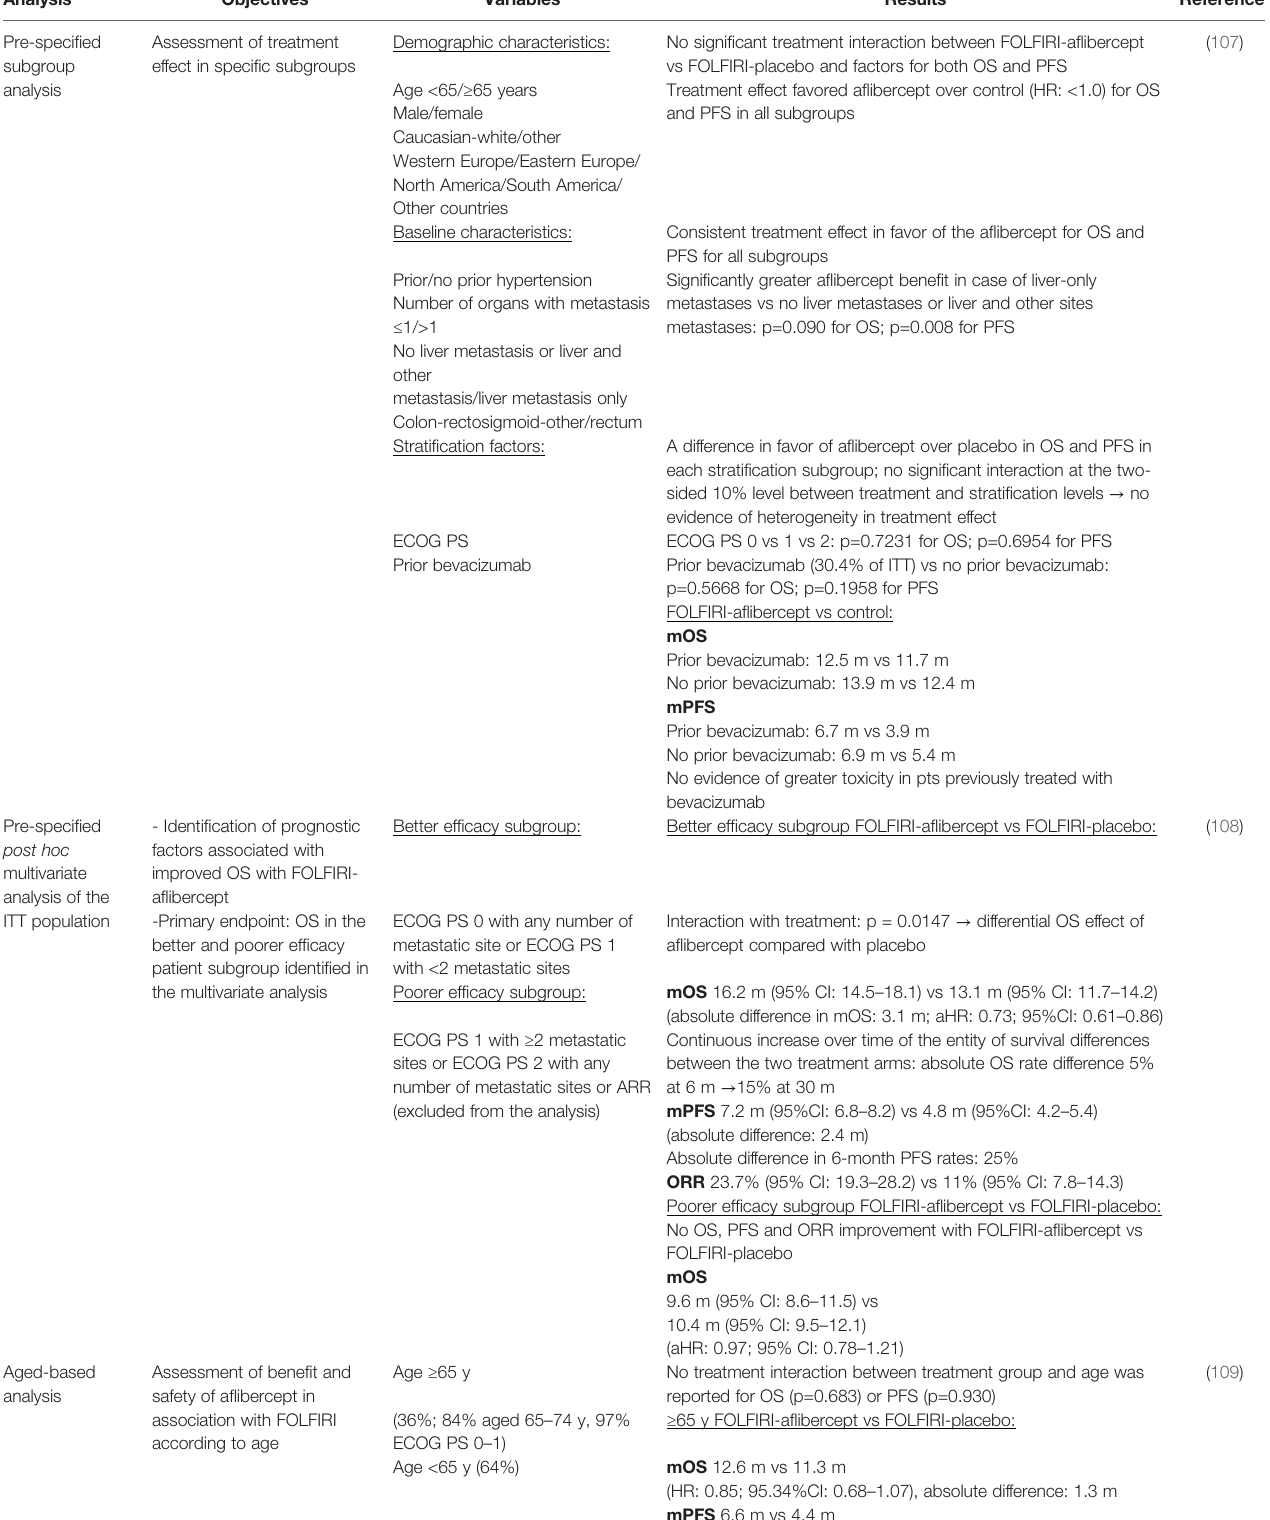
TABLE 4 | Pre-speci fi ed analysis of the VELOUR